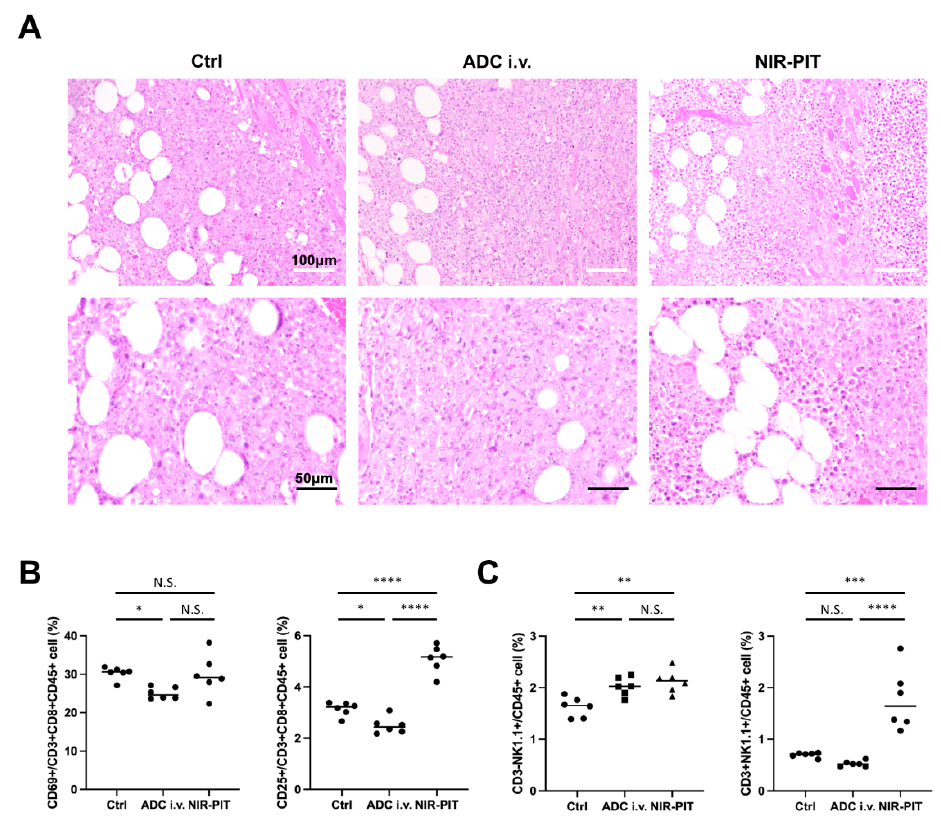
Figure 4. Pathological analysis of EL4-luc tumor after GD2-targeted NIR-PIT. ( A ) Hematoxylin and eosin staining of tumors resected one day after NIR-PIT (White scale bars, 100 µ m; black scale bars, 50 µ m). ( B , C ) Immune cell response after GD2-targeted NIR-PIT was analyzed by flow cy-